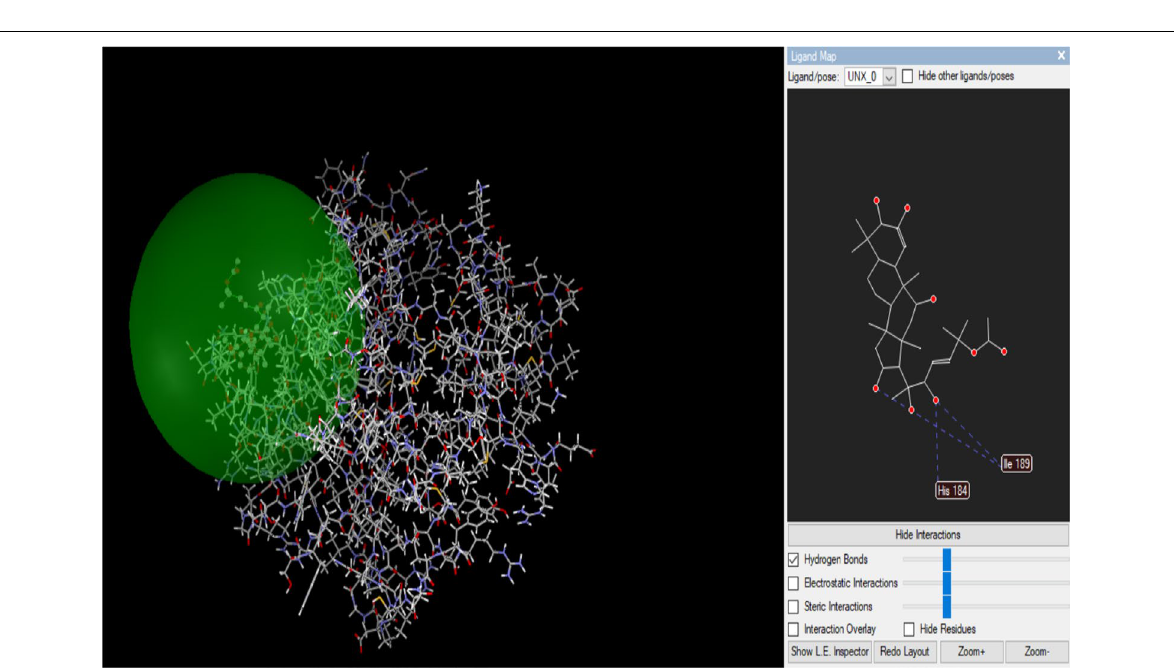
Fig. 17 The 3D representation of Cucurbitacin E at the active site of G. mellonella GST enzyme (Hydrogen bonds; Ile 189, Ile 189; His